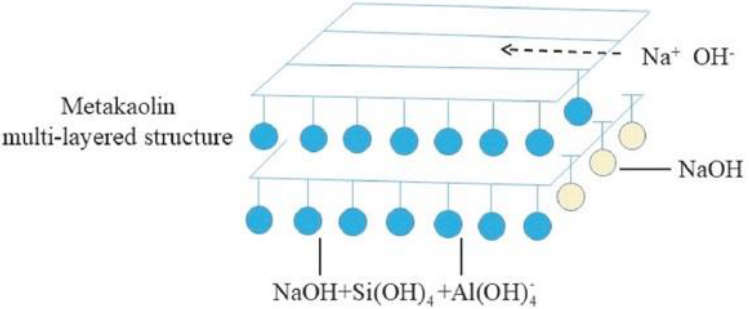
Figure 4. Schematic diagram of metakaolin particles subjected to chemical action